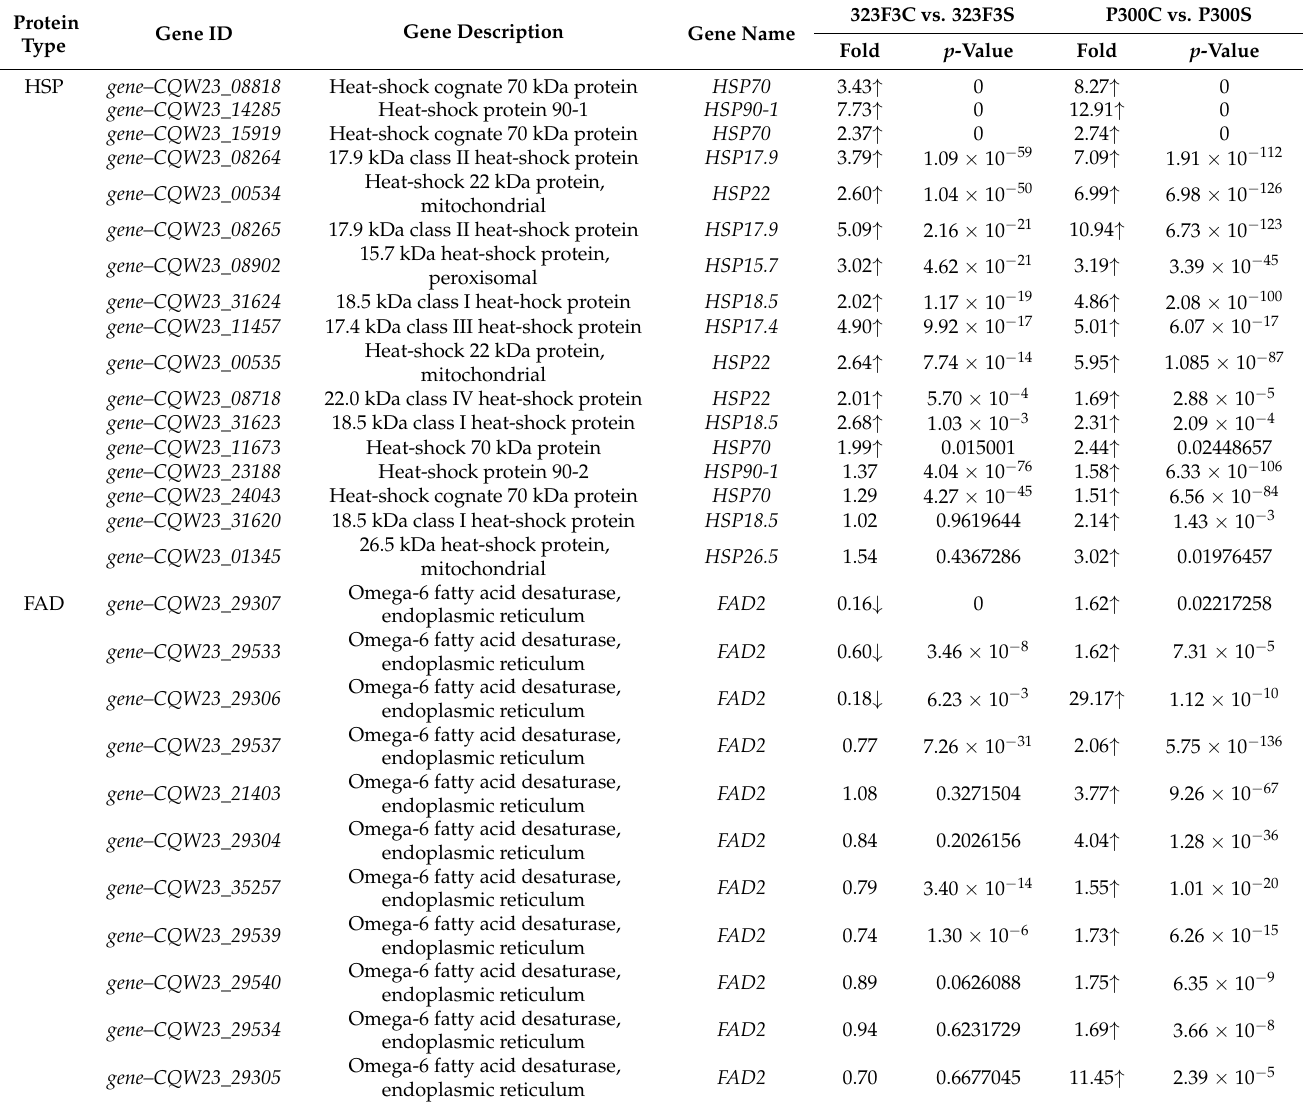
Table 2. The up-regulated genes encoding HSP and FAD type proteins in 323F3C vs. 323F3S and P300C vs. P300S.